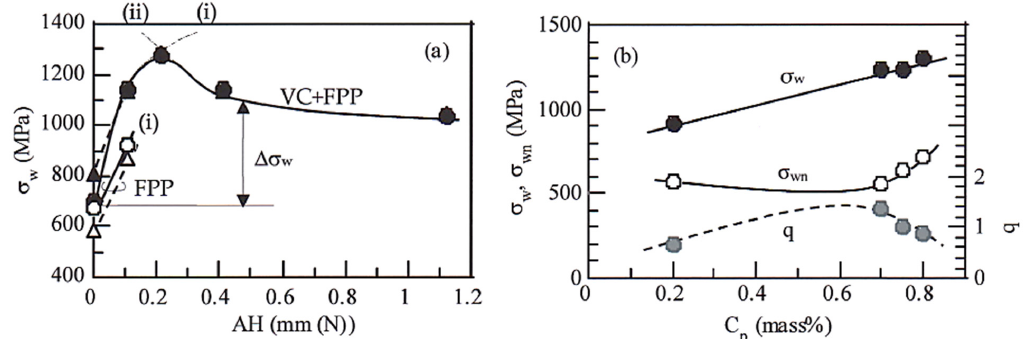
Figure 19. ( a ) Arc-height (AH) dependence of smooth fatigue limit ( σ w ) in 0.2%C–1.5%Si–1.5%Mn–1.0%Cr–0.05%Nb TM steel ( ●○ ) and JIS-SNCM420 Q&T steel ( △▲ ) subjected to fine particle peening (FPP) treatment after heat-treatment (the DQ-P process, T p = 180 ° C) and vacuum carburization (VC) followed by the DQ-P process ( T p = 180 ° C) and then fine particle peening (FPP) treatment (VC+FPP) [147]. ( b ) Carbon potential ( C p ) dependence of σ w , notch-fatigue limit ( σ wn ) and notch sensitivity ( q ) in the TM steel subjected to VC+FPP treatment [148]. (i) Increases in hardness and compressive residual stress, (ii) fish-eye crack fracture at a high depth. Refs. [147,148] are reprinted with permissions from Springer Nature: Metall. Mater. Trans. A, Copyright 2021 and from Taylor & Francis: Mater. Sci. Technol., Copyright 2021, respectively.